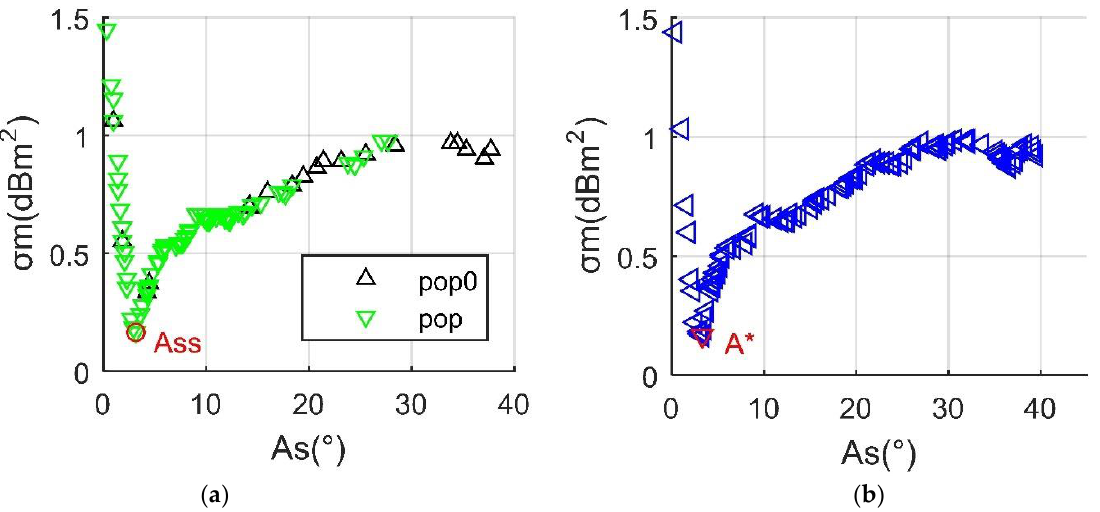
Figure A1. Average RCS of the aircraft, where α n = 50° , α m = 90°, β = 0°, and F rh =5 GHz. ( a ) Auto-swept scheme, ( b ) SA results.